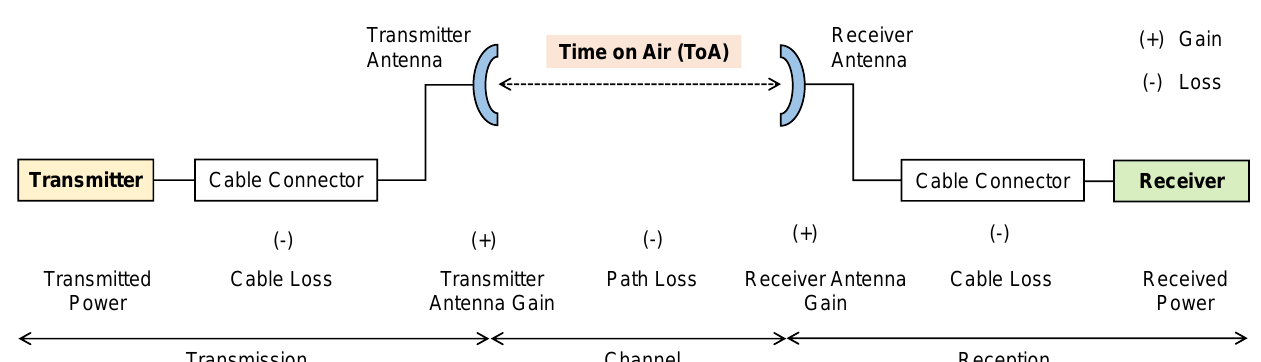
Figure 14. LoRa packet format.